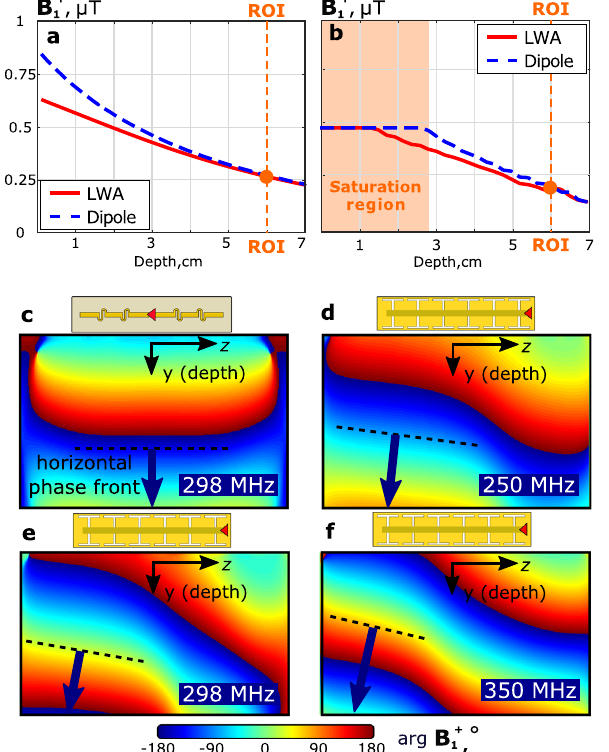
Fig. 7 Numerical and experimental B þ magnitude and phase pro fi les. 1 Simulated ( a ) and measured ( b ) B þ vs. depth pro fi les for the LWA and 1 fractionated dipole antenna element in the phantom (pro fi les were plotted along the corresponding dashed lines shown in Fig. 6a – d); simulated phase patterns for B þ in the phantom for the dipole antenna at 298MHz ( c ), and for 1 the LWA at 250MHz (d), 298MHz ( e ) and 350MHz ( f ). The tangent to the phase front for each phase pattern is indicated with a black dashed line.